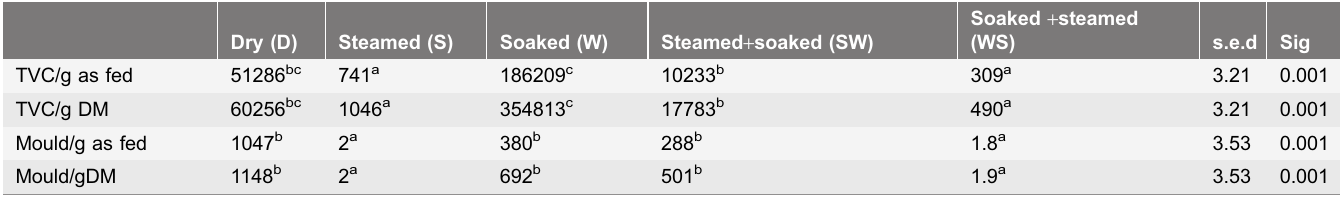
Table 4. Geometric mean numbers (CFU/g) of bacteria (TVC) and mould in five UK conserved hays when subjected to five different wetting treatments. Dry